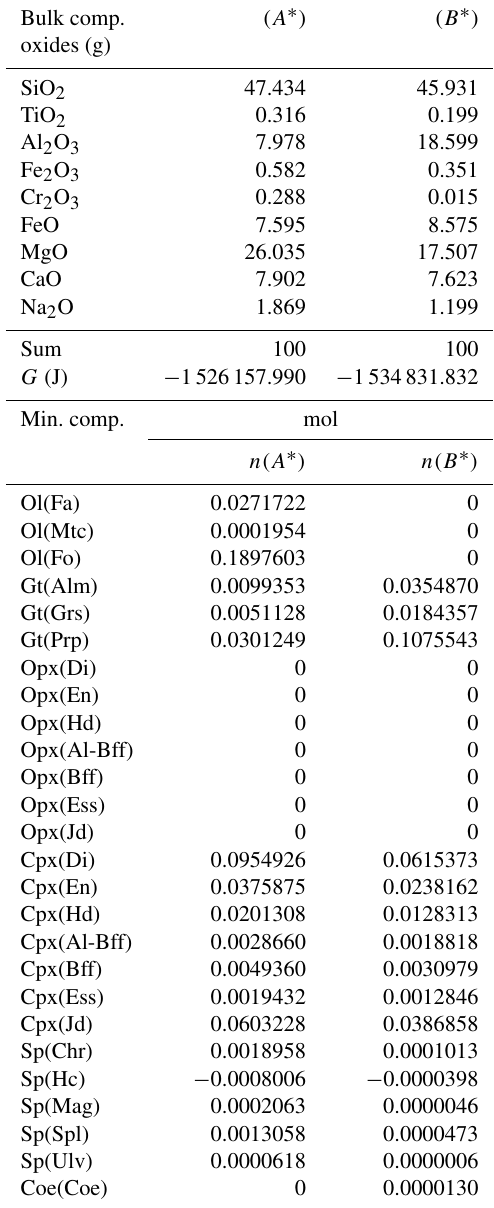
Table 4. Normalized bulk composition ( A ∗ ) and ( B ∗ ) in the two subsystems taken from the results of the model in Table 3, ( A ) and ( B ). The lower part of the table shows the equilibrium mineral com- position computed with the program AlphaMELTS for each subsys- tem separately. Bulk